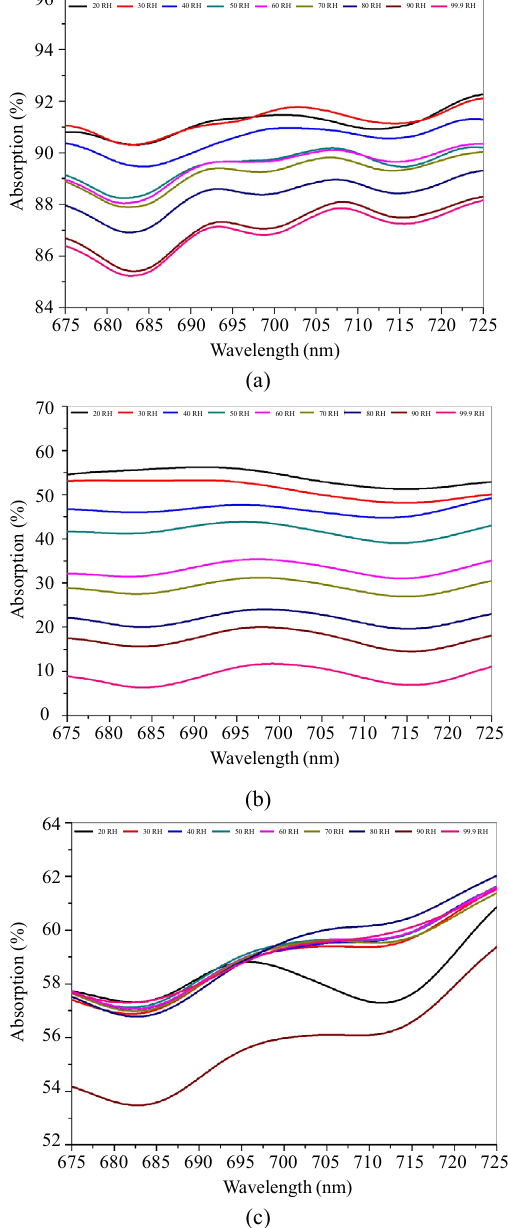
Fig. 7 Percent absorptions of the tapered optical fiber coated with (a) 10 ml GO + 0.2 g PVA, (b) 10 ml GO + 0.3 g PVA, and (c) 10 ml GO + 0.4 g PVA composite films under RH ranging from 20% to